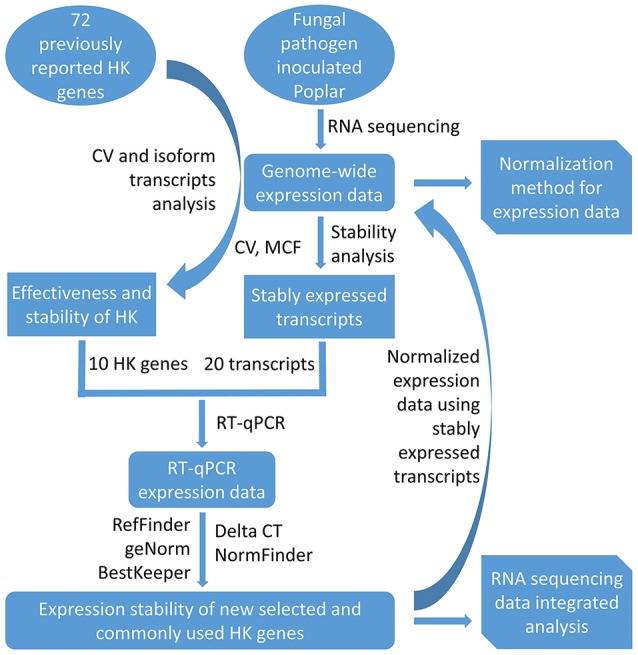
The workflow of selection of HK genes from transcript data.